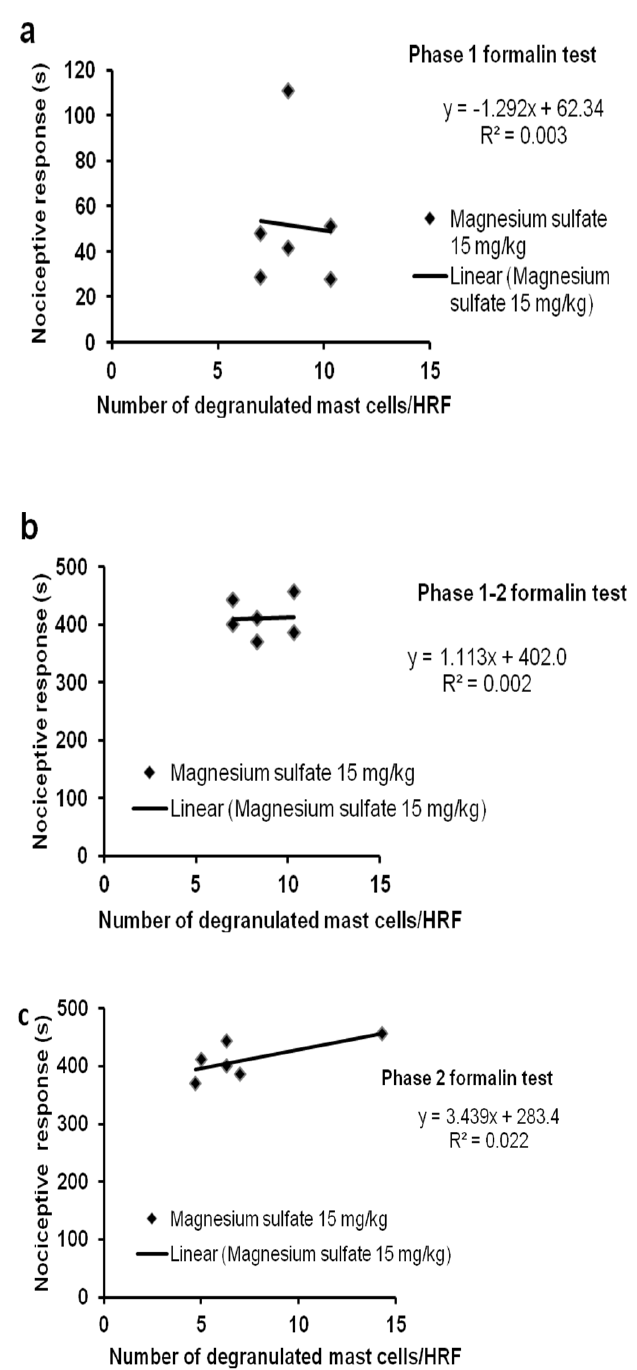
Figure 8. Linear regression analysis of pain and degranulated mast cells after magnesium treatment in the first ( a ), first–second ( b ), and second ( c ) phase of the formalin orofacial test. The nociceptive response (in seconds) was expressed as the total time pain was experienced during the first ( a ) or second ( b , c ) phase of the formalin test and compared with the degranulation of mast cells/high representative fields (HRF), during the first ( a , b ) or second ( c ) phase of the formalin test. Each point represents the values obtained from one rat (in a total of 6 rats). The calculated Pearson’s correlation coefficients did not show a statistically significant relationship between lip mast cell degranulation and pain after the treatment with magnesium ( a – c ).